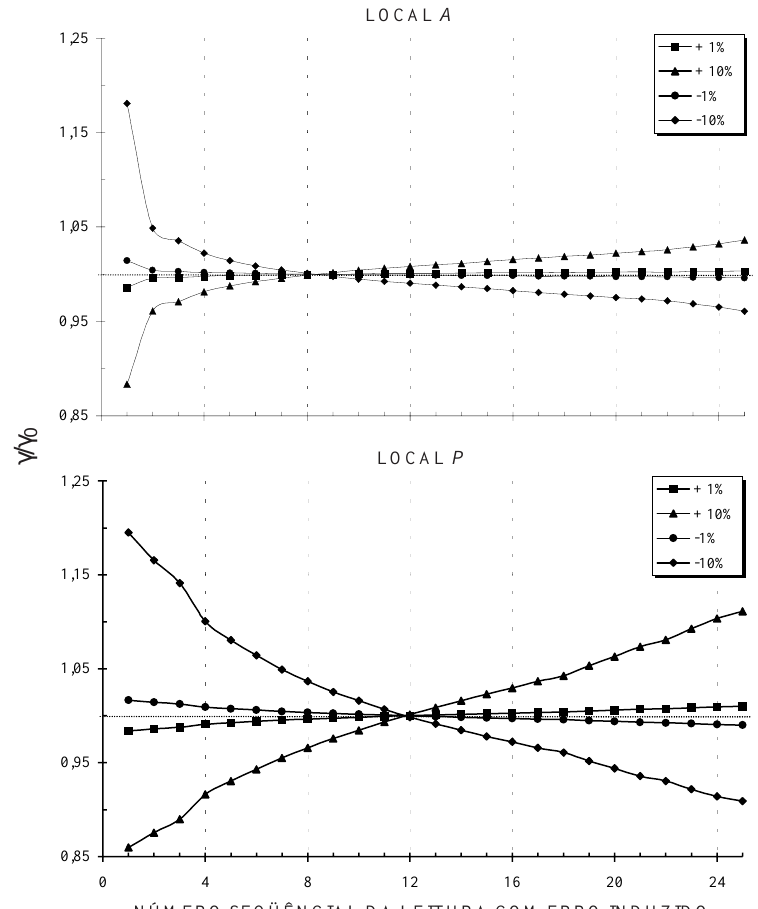
Figura 9. Valores de ggggg para o local A (0,20 m) e local P (0,30-0,45 m), obtidos da indução de um erro de -10 %, -1 %, +1 % ou +10 %, uma por uma em cada uma das leituras do TDR na mesma profundidade, relativos aos valores de ggggg , obtidos do conjunto intacto de 0